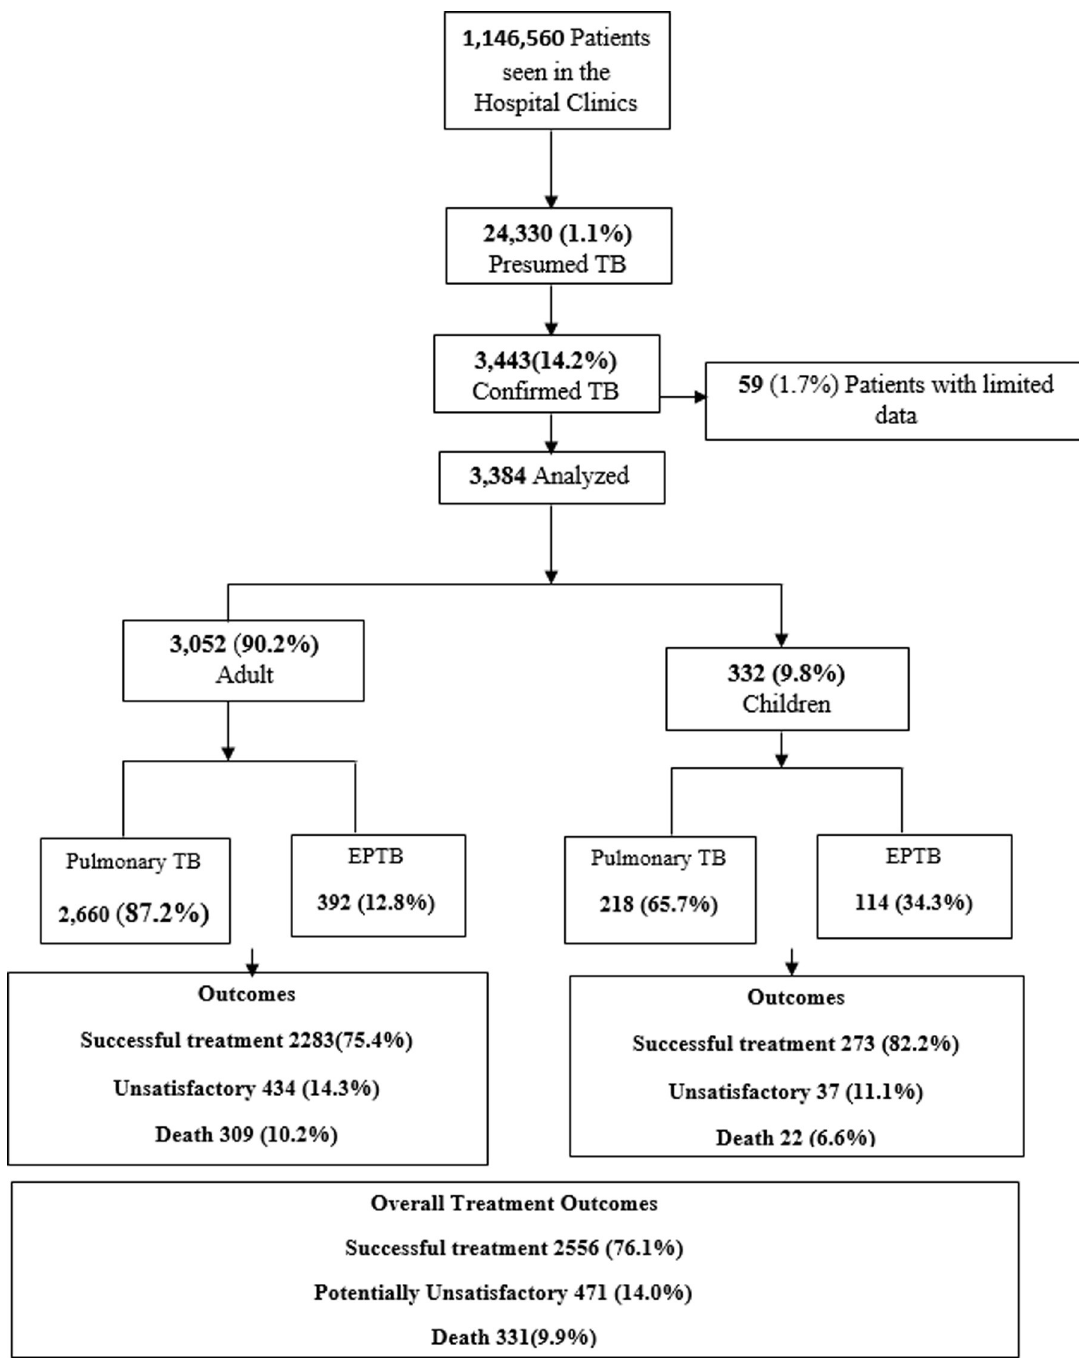
Fig 1. The flow diagram of program enrolment and treatment outcome of TB cases. The flow diagram of program enrolment and treatment outcome of TB cases. The final outcome data excludes 26 missing data points (TB:tuberculosis; EPTB: Extrapulmonary